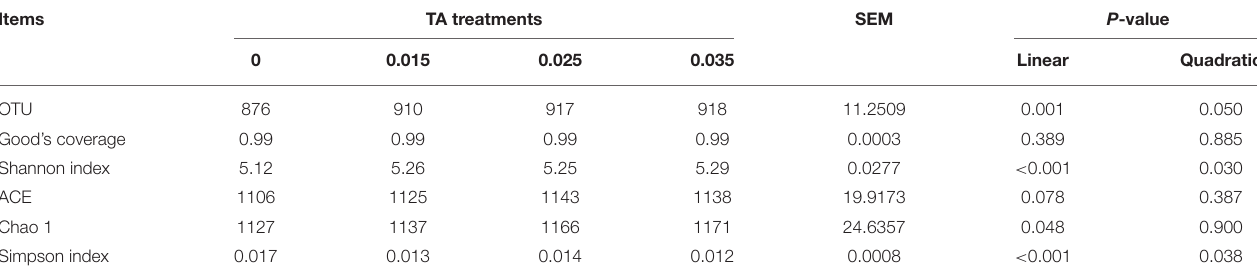
TABLE 3 | Effects of tannic acid concentration treatments of ground corn on the number of observed species and alpha diversity of bacterial community